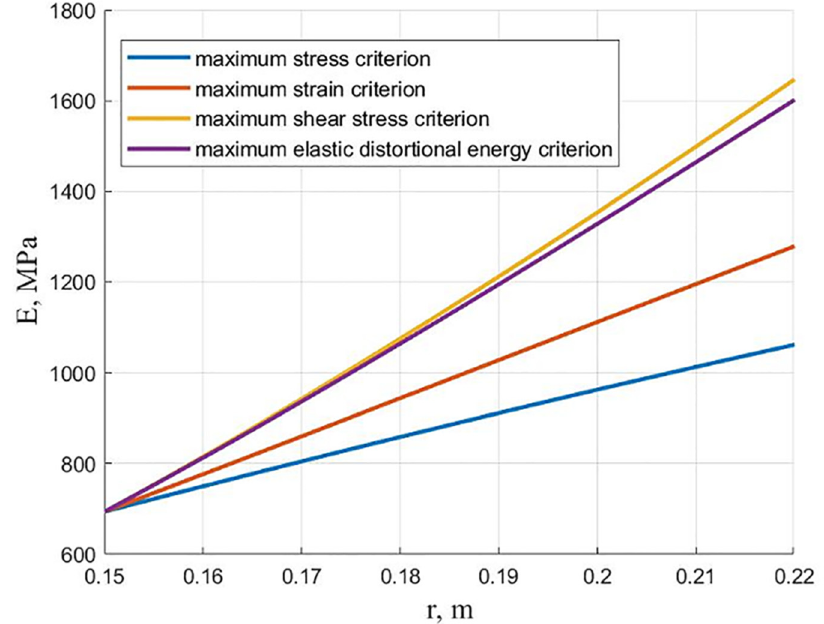
Figure 2. The dependencies of the modulus of elasticity on the radius for an equally stressed cylinder using various failure criteria.